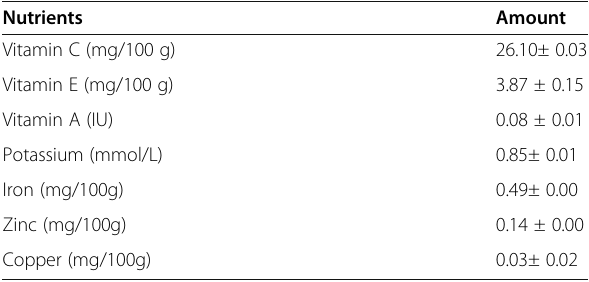
Table 2 Preliminary mineral and vitamin contents of Cola hispida leaf extract